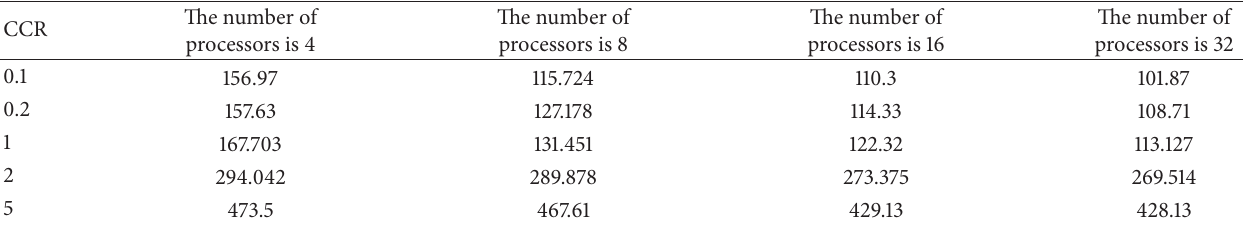
Table 14: The experiment results for the random graph under different task CCRs, the number of tasks is 50. The number CCR